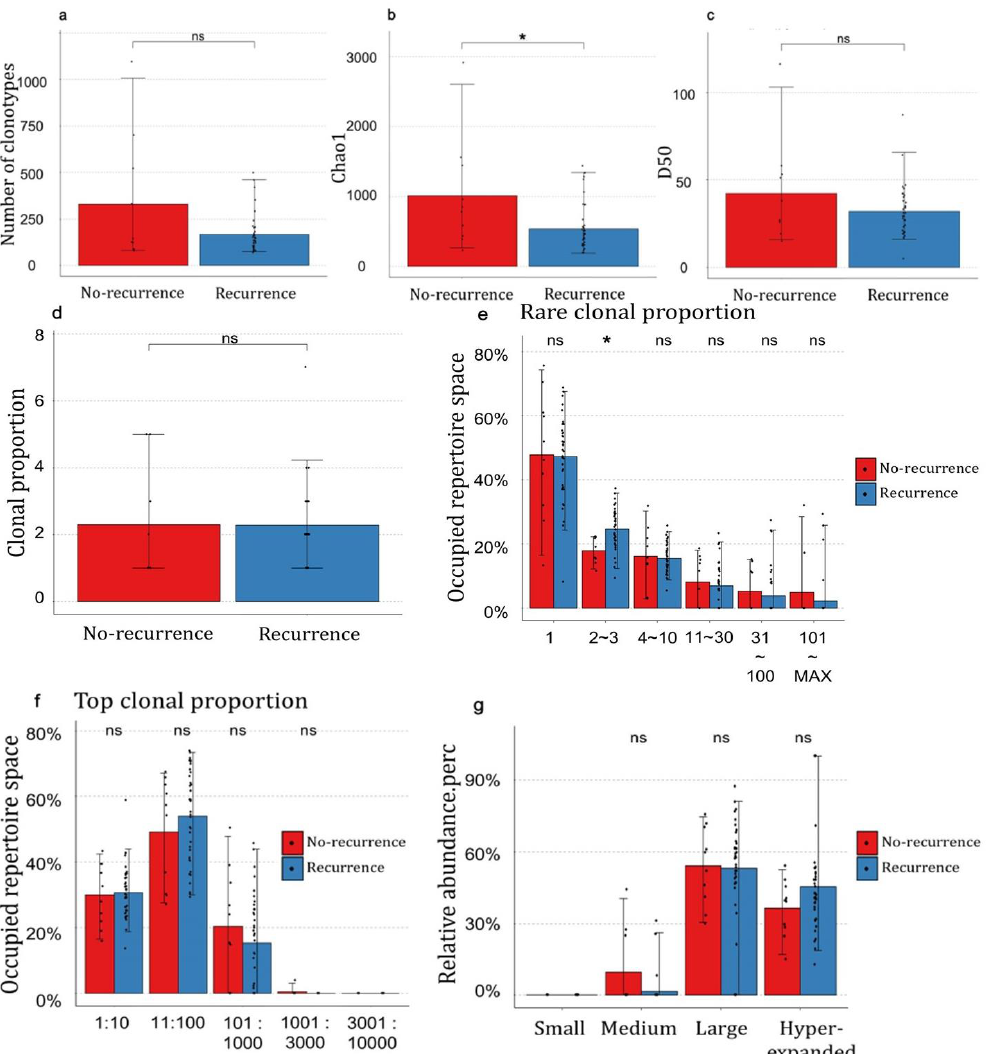
Figure 2. Expression patterns of TCR repertoire genes according to the patient’s prognosis. ( a ) The counts of unique TCR clonotypes; ( b , c ) The richness and diversity of TCR between the recurrence and no-recurrence groups estimated using Chao1 and the D50 diversity index; ( d – g ) The clonality of TCR segments between the recurrence and no-recurrence groups; ( d ) The numbers of clonotypes occupying 12% of the TCR repertoire; ( e ) The proportion of rare clonal clonotypes with specific counts; ( f ) The proportion of top clonal clonotypes with specific indices; ( g ) The relative abundance of the small, medium, large, and hyperexpanded clonotypes. ( a – g ) Non-significant p -values are indicated as ns, and p -values < 0.05 are indicated as * .